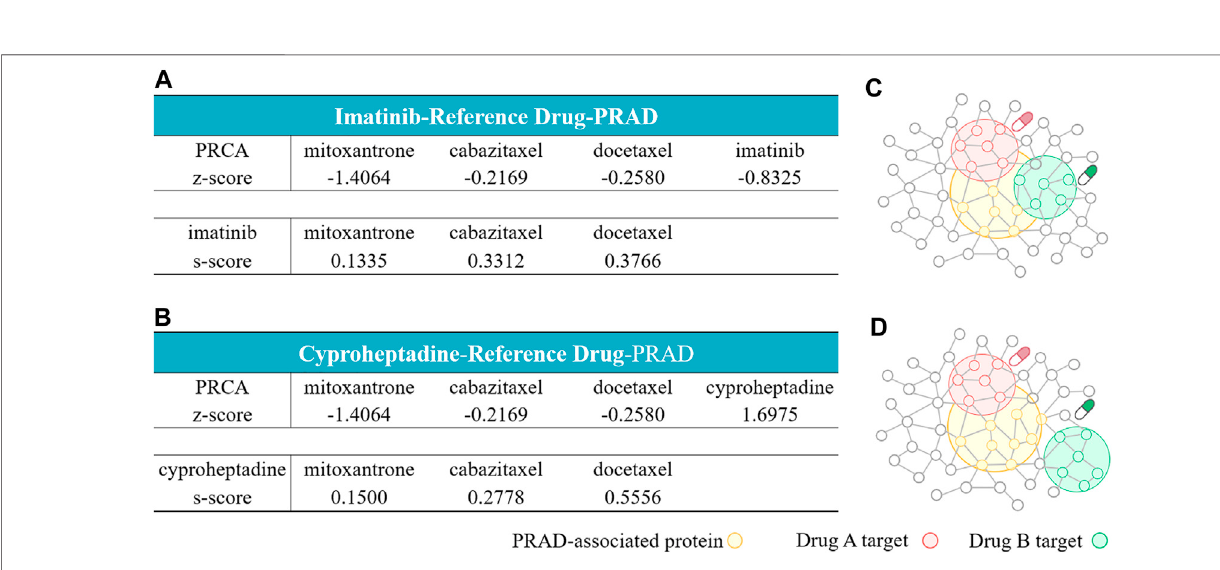
Frontiers in Pharmacology |